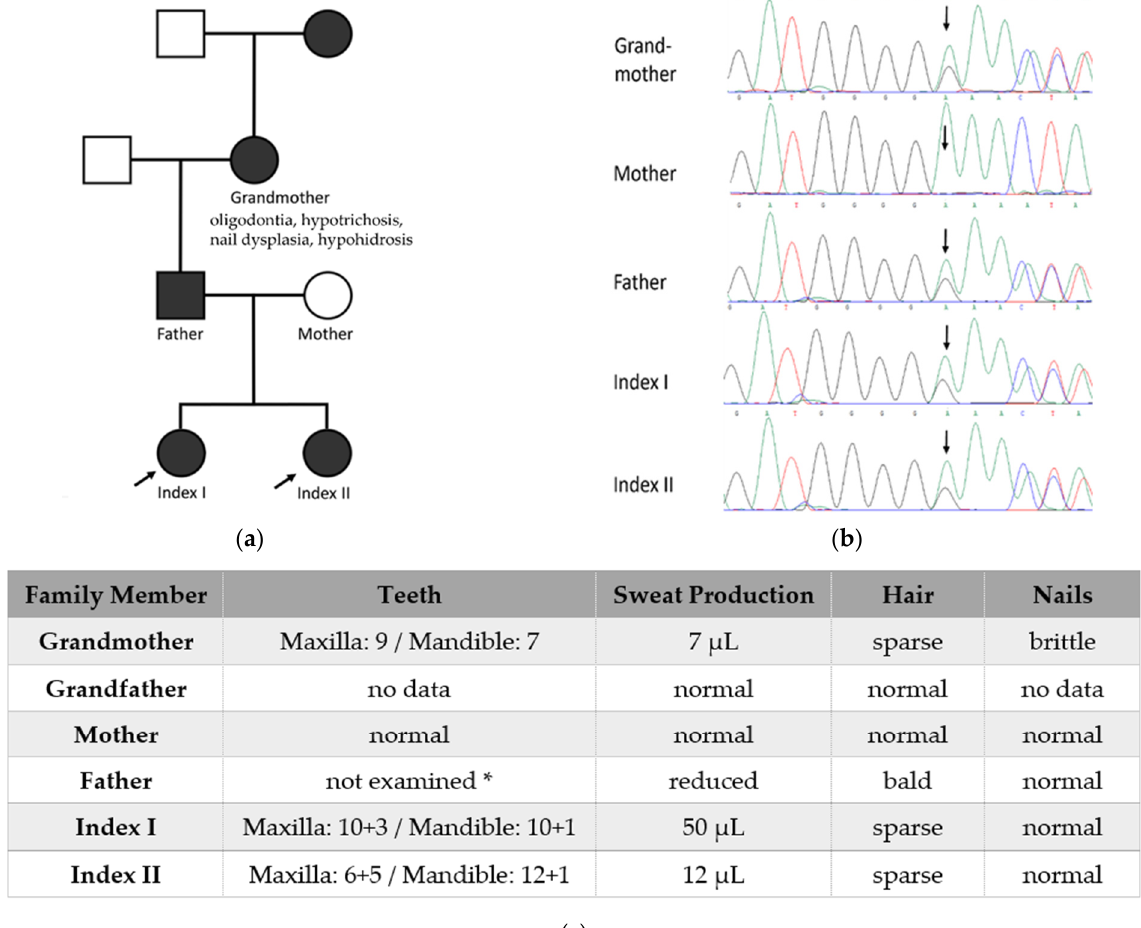
Figure 3. ( a ) Family pedigree showing segregation of the pathogenic LRP6 variant. Affected male individuals are indicated by black squares, affected females by black circles. Index patient I (arrowed) was subjected to whole exome sequencing; ( b ) Sanger sequencing of the family members’ DNA samples at the mutation site; ( c ) Phenotype in different patients: The number of teeth at the time of radiographic examination is given, the first digit refers to the permanent teeth, the second digit to deciduous teeth. In the grandmother and both index cases, missing permanent dentition was congenital. The ability to sweat is indicated by pilocarpine-induced sweat production within 30 min. * all teeth extracted in